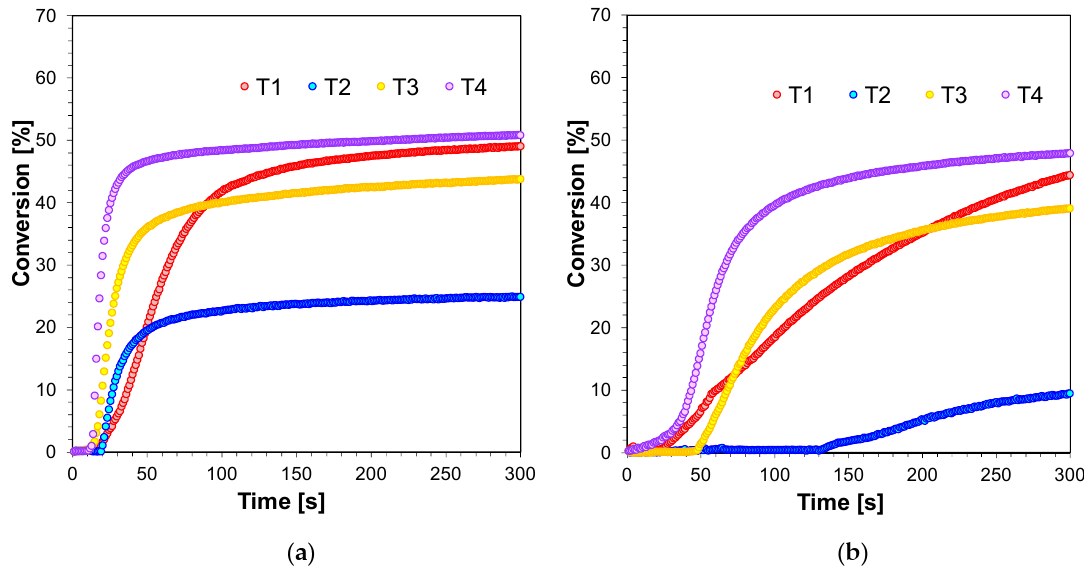
Figure 6. Polymerisation profiles of TMPTA (acrylate function conversion vs. irradiation time in laminate in the presence 2,4-diethyl-thioxanthen-9-one derivatives (0.2% w / w ) upon exposure to ( a ) the visible LED@405 nm ( b ) the visible LED@420 nm. The irradiation starts at t = 10 s.